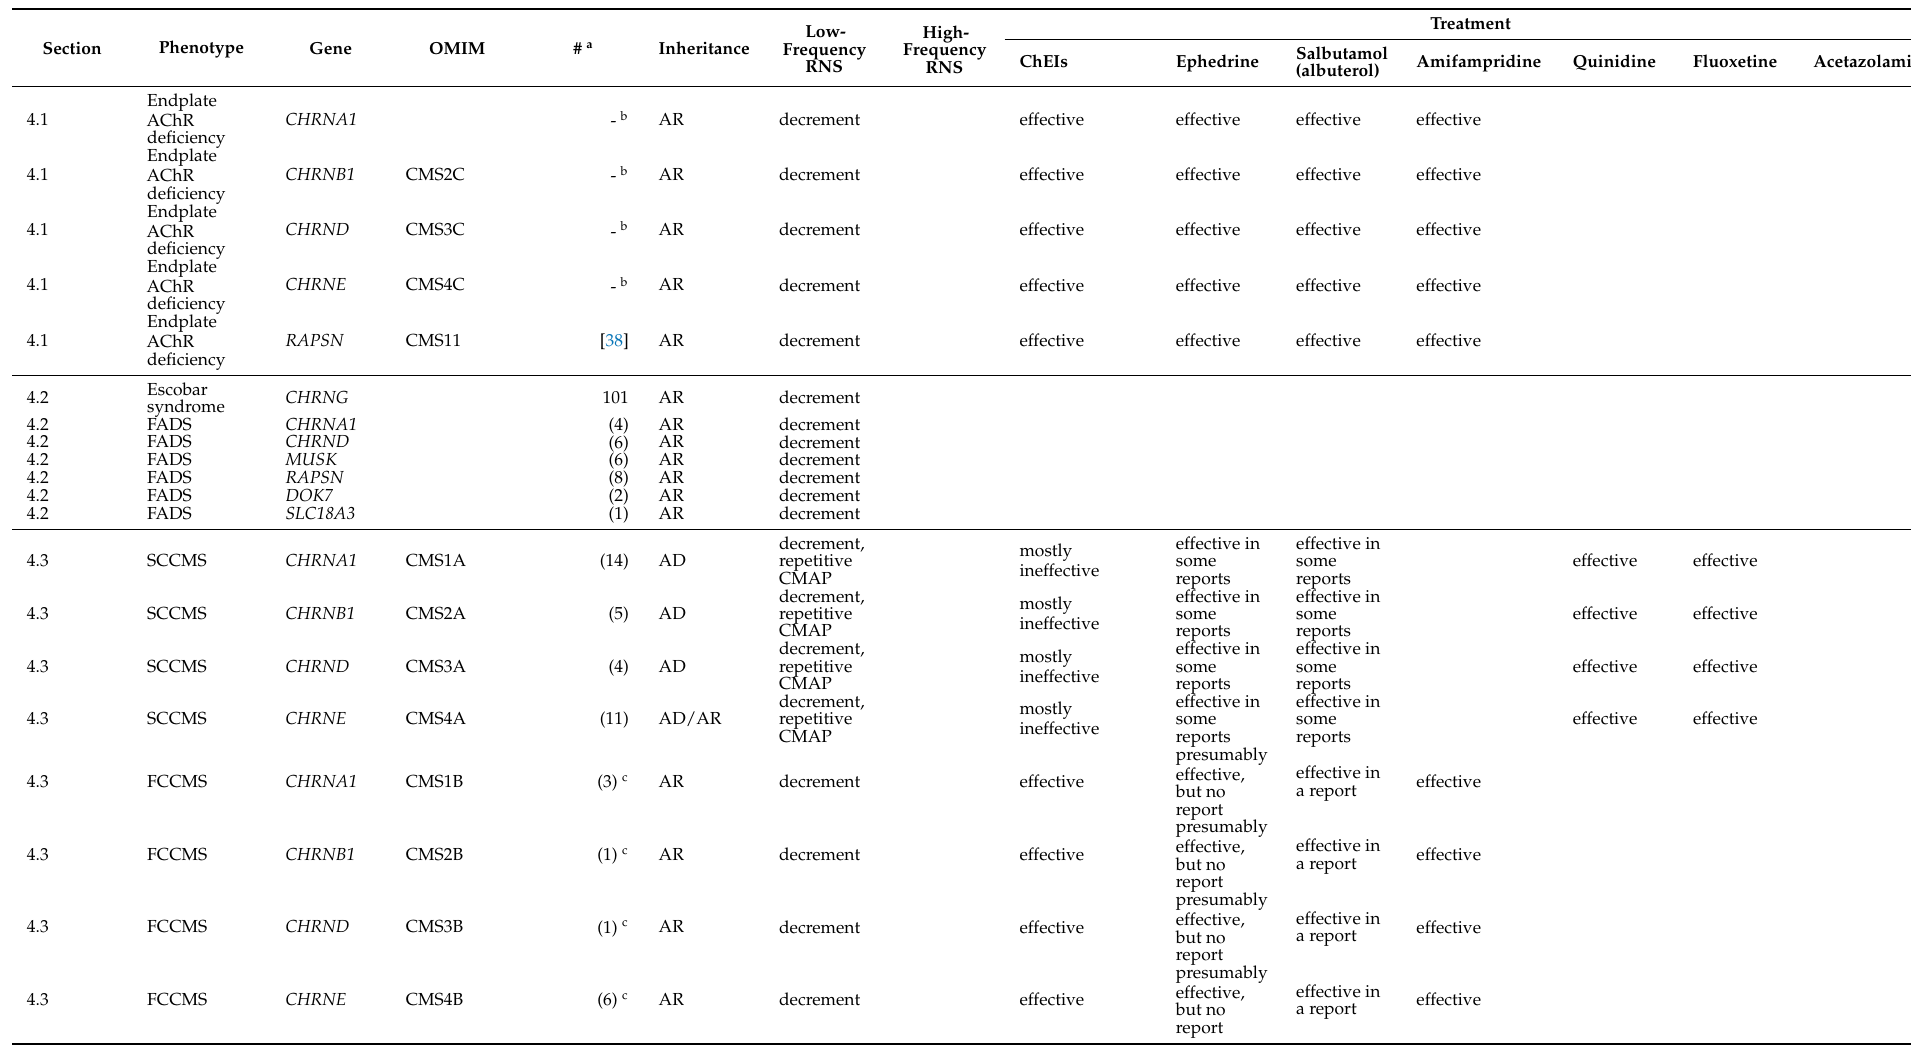
Table 1. Electrophysiological features and therapies of congenital myasthenic